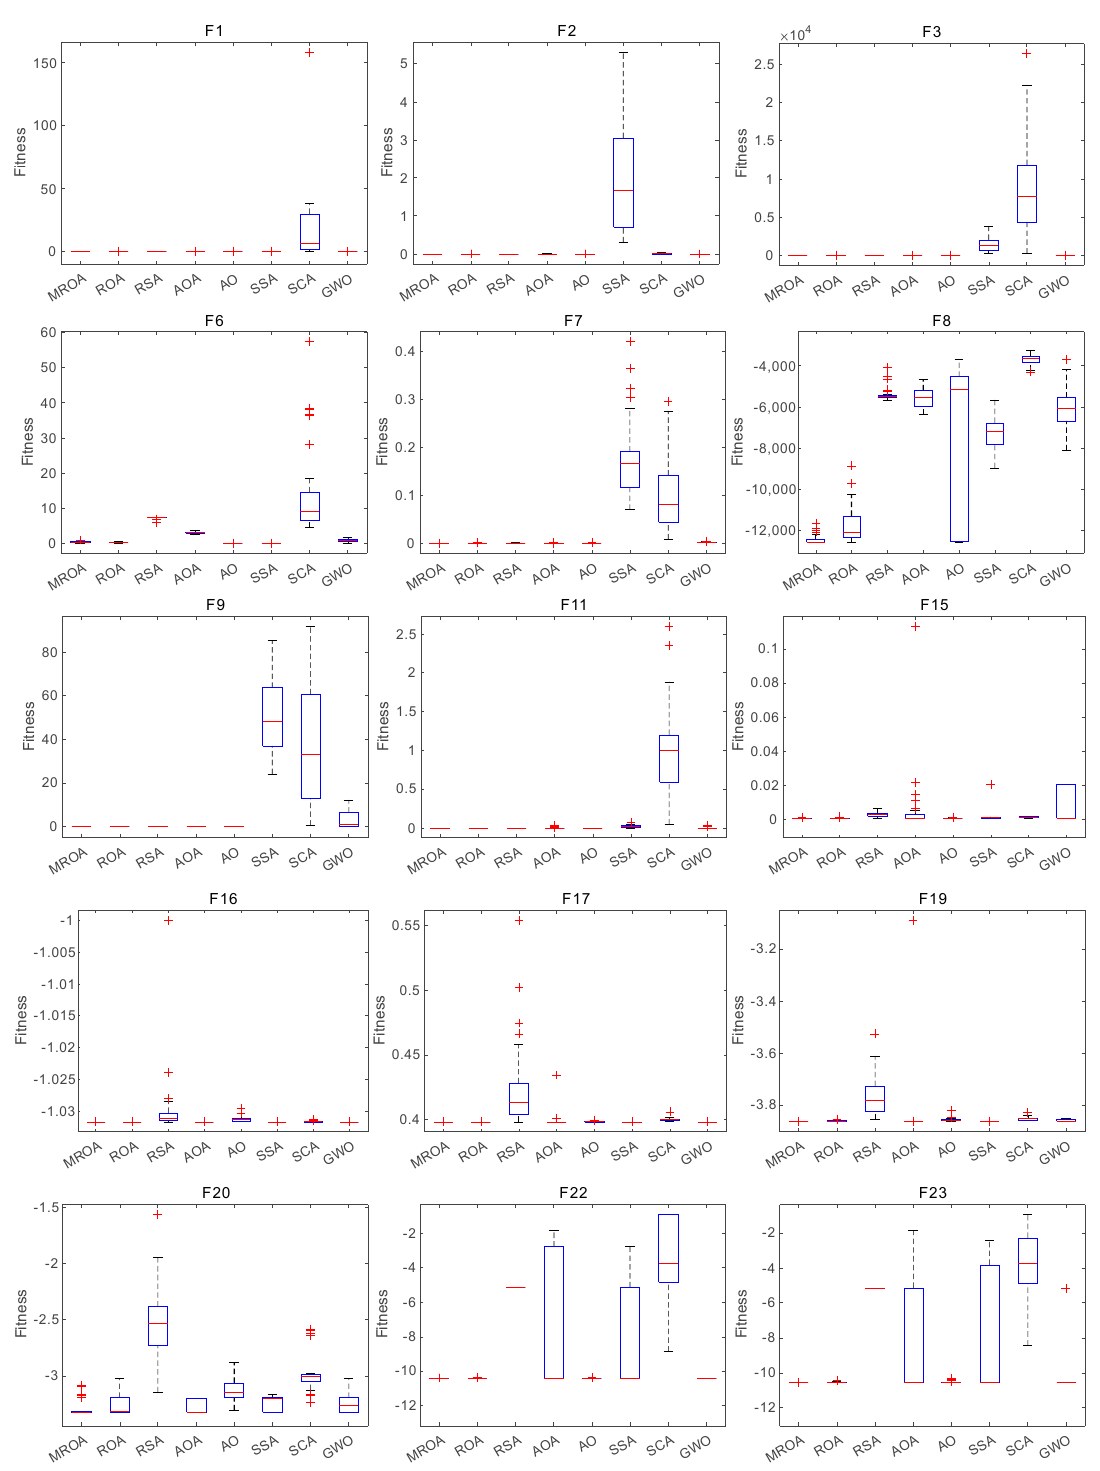
Figure 7. Boxplot behavior of algorithms on some functions.